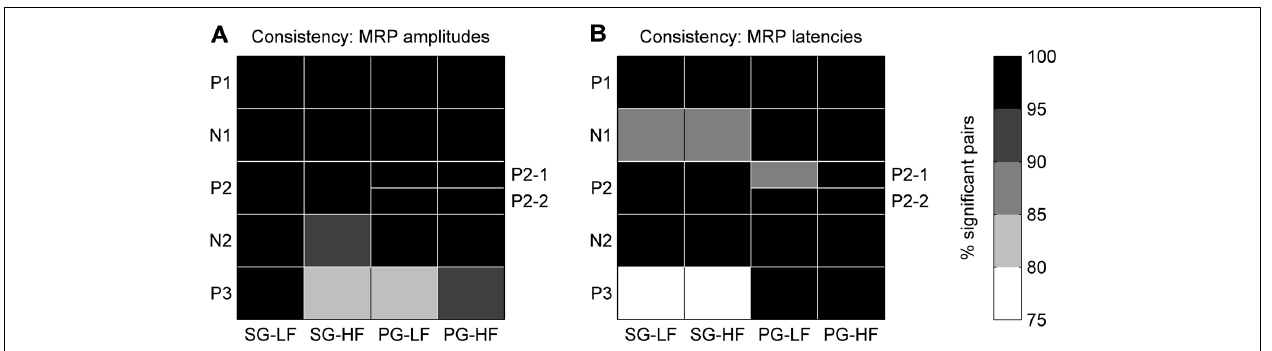
FIGURE 5 | Consistency of peak amplitude (A) and peak latency (B) maps across all selected subsessions. The gray color code corresponds to the percentage of significant data pairs for each component and behavioral